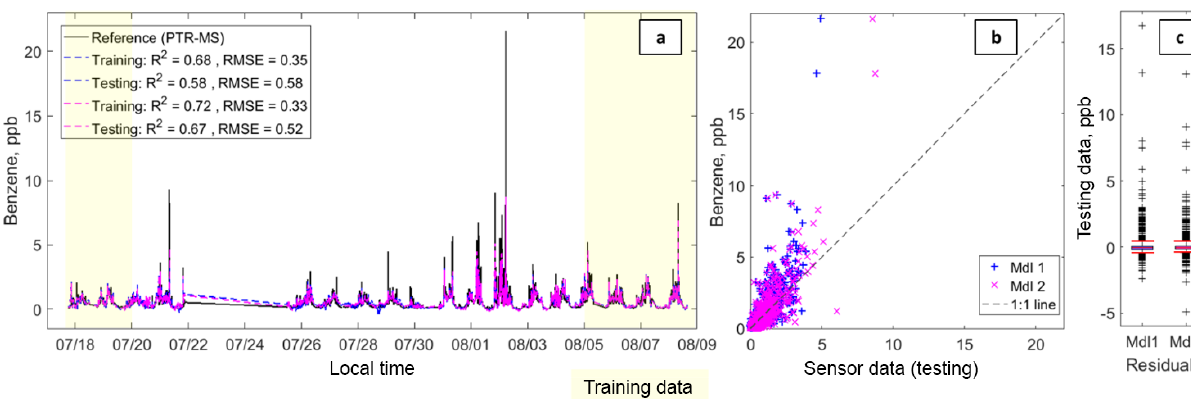
Figure 2. Panel (a) depicts a time series including the benzene data from the PTR-QMS and the fitted sensor data from Model 1 (in blue) and Model 2 (in fuchsia). The text box includes the following statistics: coefficient of determination ( R 2 ) and the root-mean-squared error (RMSE) in that order for each testing and training dataset. Panel (b) depicts a scatter plot of the testing data for Model 1 (in blue) and Model 2 (in fuchsia); the 1:1 line has also been added. Panel (c) depicts box plots of the residuals with the whiskers at the fifth and 95th percentiles (in red).